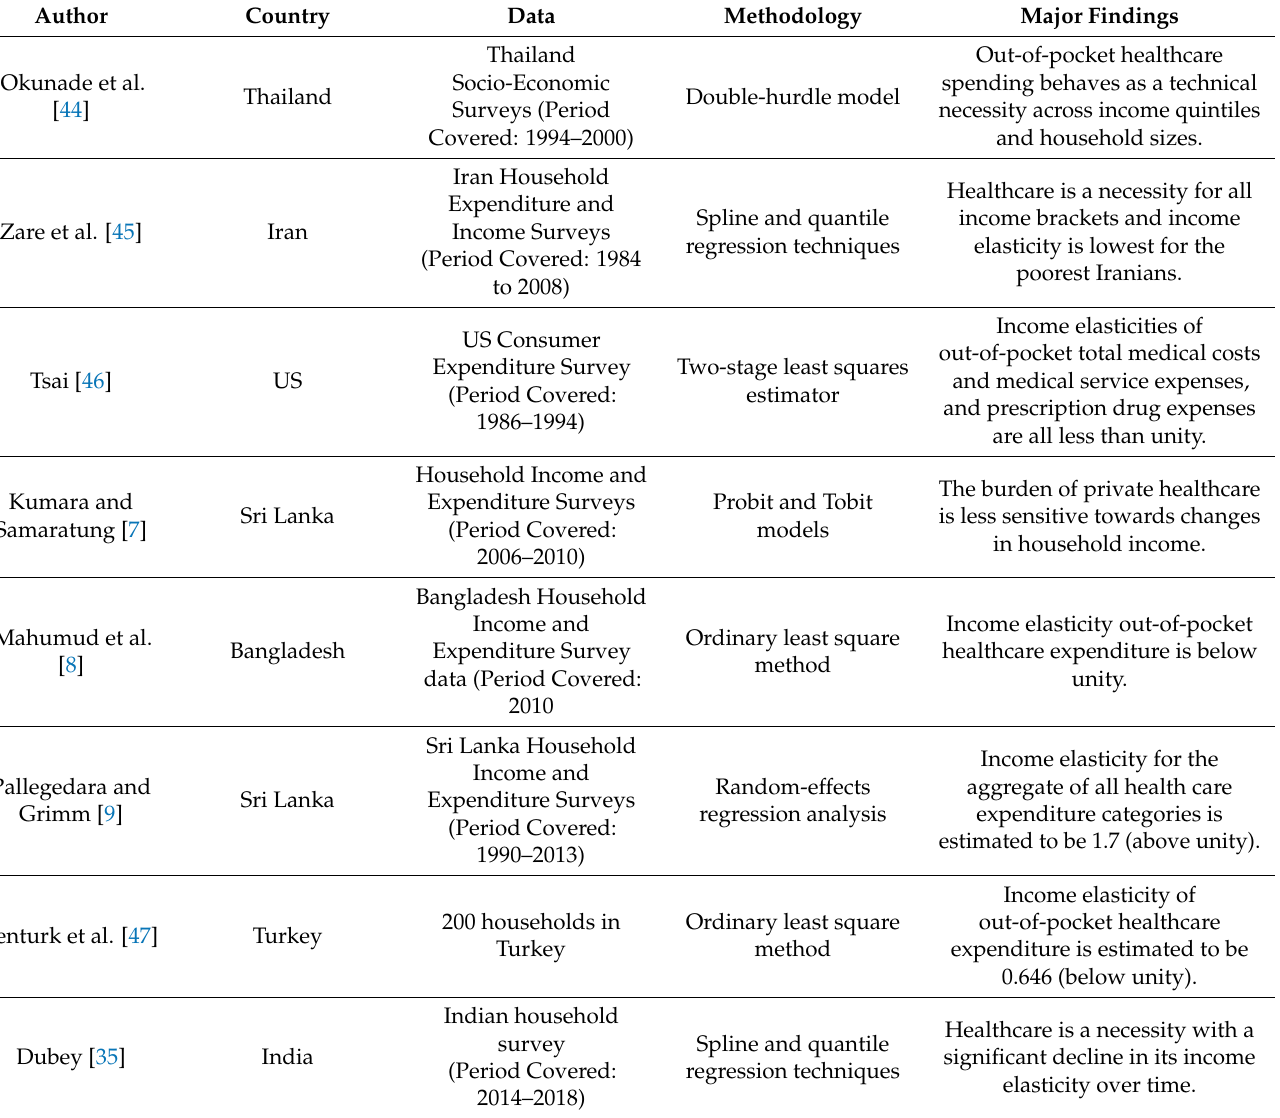
Table 1. Summary Selected Empirical Studies on Income Elasticity of Healthcare